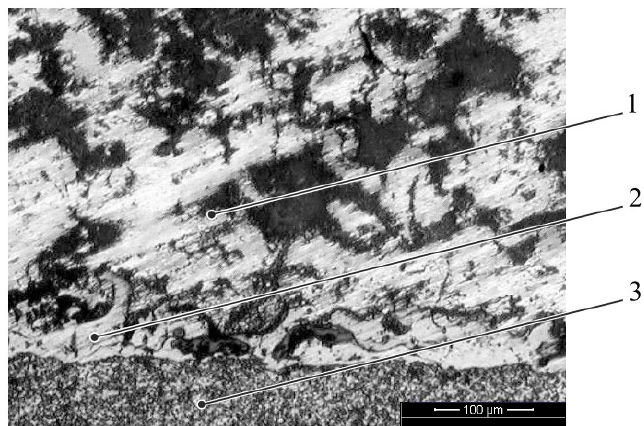
Figure 8. Structure of a sealing coating of aluminum–boron nitride (Al-BN), deposited on the sublayer of Ni–Al alloy after laser treatment: 1—coating; 2—sublayer; 3—substrate of the Ni-based superalloy [103].